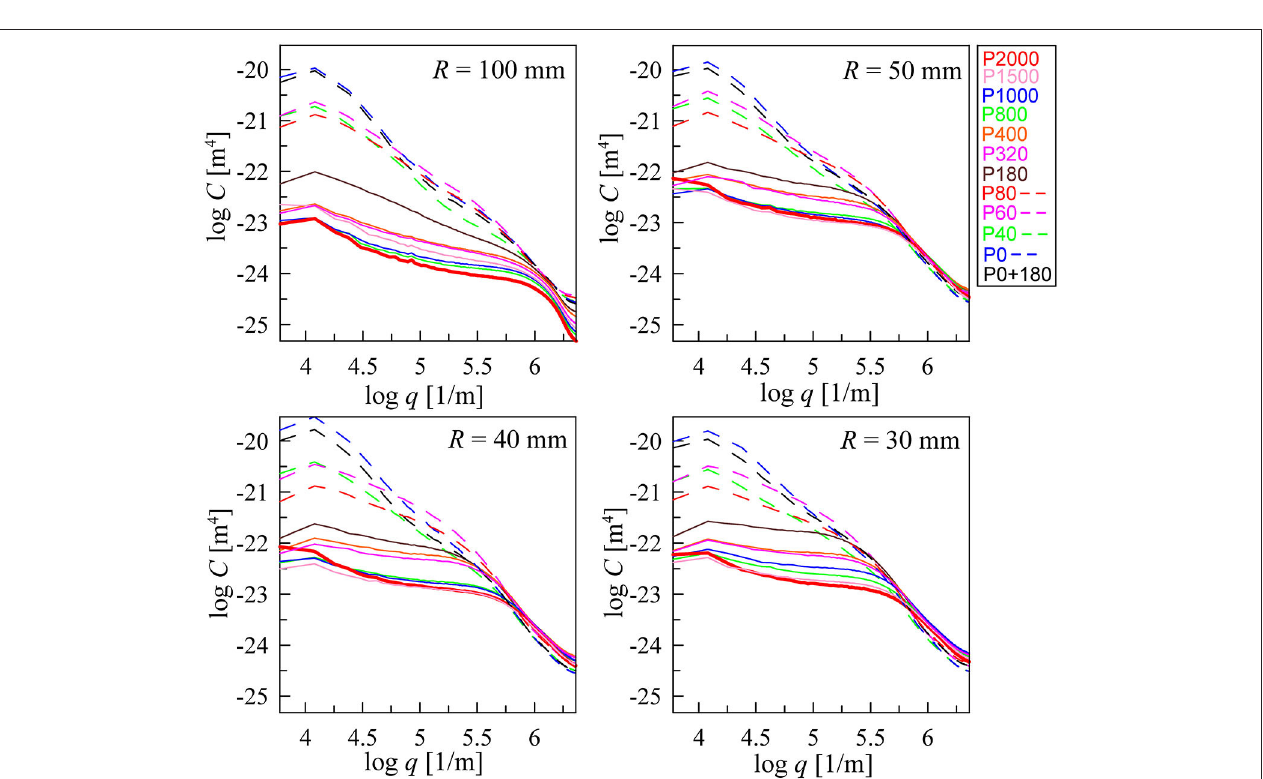
Frontiers in Mechanical Engineering |